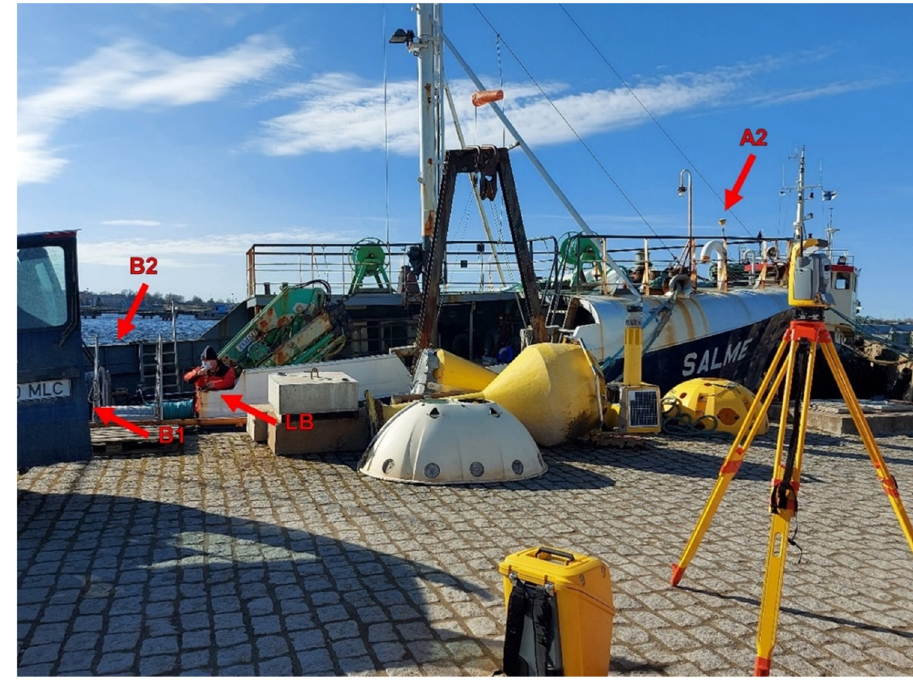
Figure 3: Total station survey for coordinating the ARPs ( A2 ) and benchmarks on the vessel ’ s railing ( B1, B2, and LB; note that B1 is behind the car )